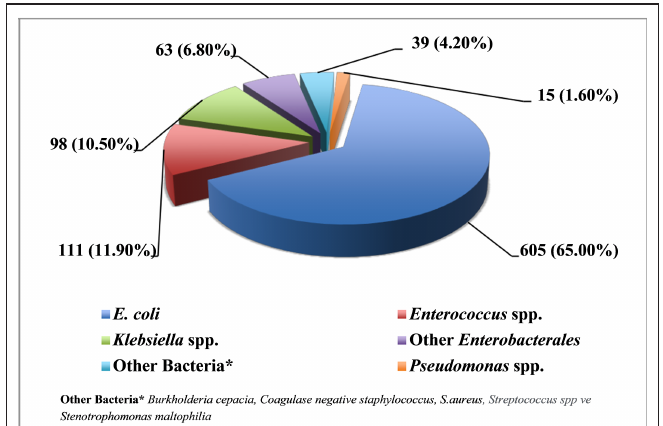
Figure 1. Microorganisms isolated from urine